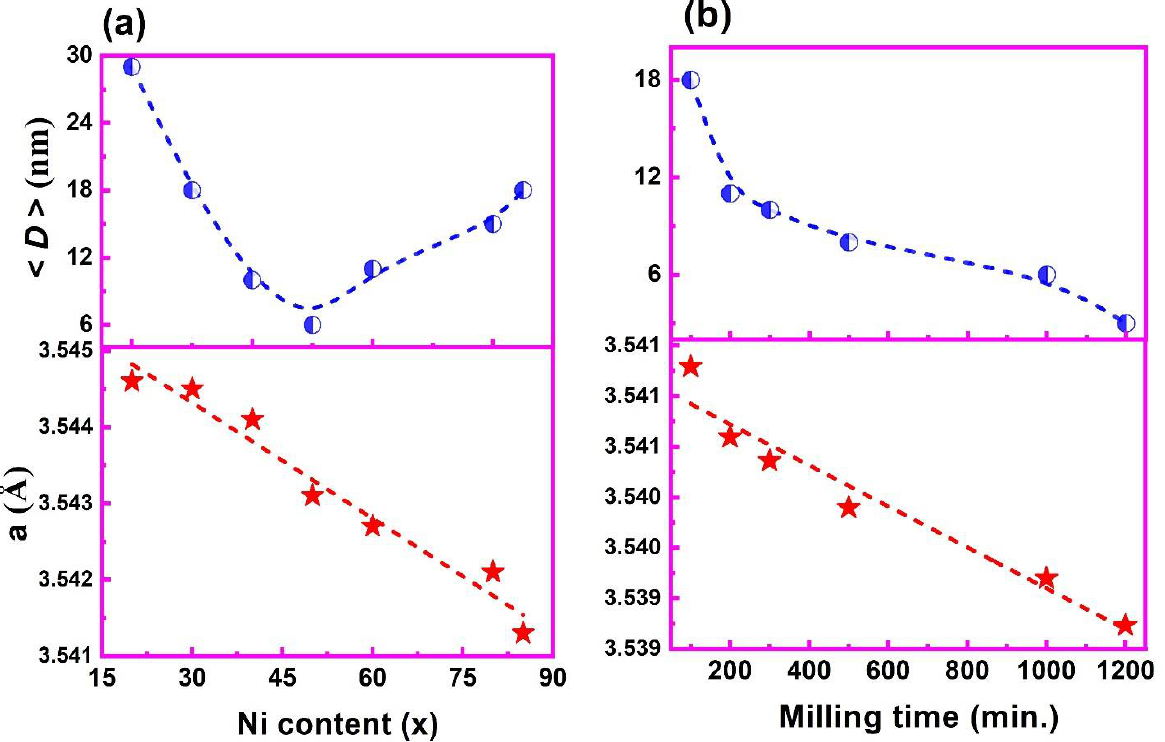
Figure 3. ( a ) Average crystallite size and ( b ) the lattice constant as a function of ( a ) Ni content and ( b ) milling time for FCC Co 100−x Ni x NPs. ( b ) milling time for FCC Co 100 − x Ni x